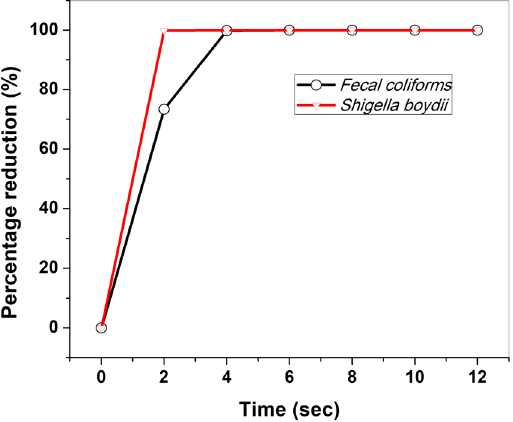
Figure 5. Percentage reduction Fecal coliform and Shigella boydii at different exposure times.